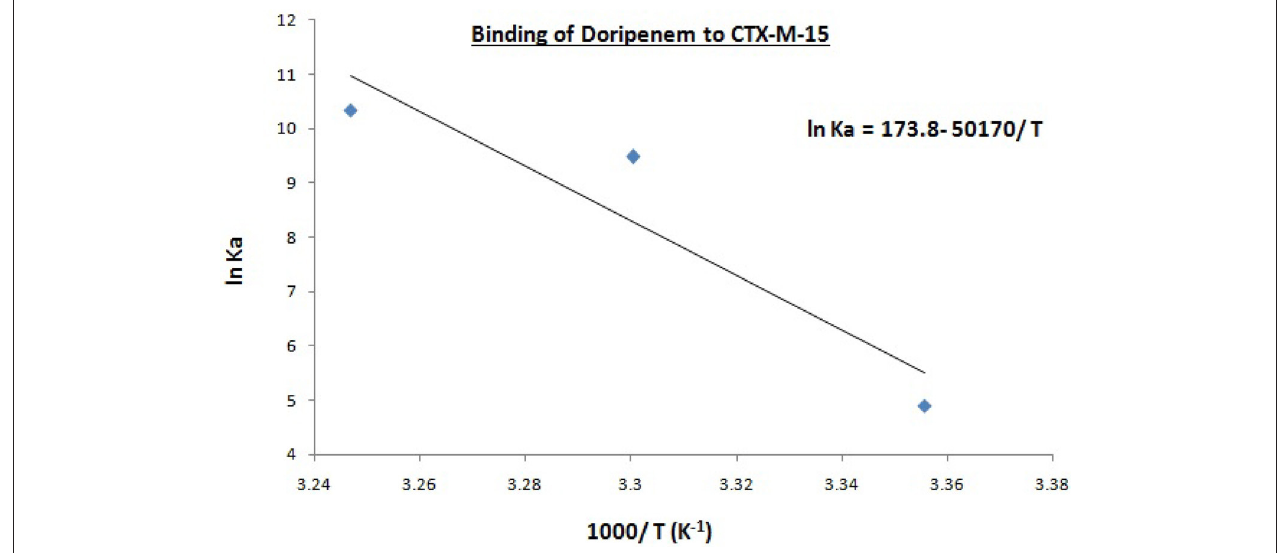
FIGURE 6 | Van’t Hoff plot for the binding of doripenem to 2 µ M CTX-M-15 at 298, 303, and 308K in the presence of doripenem (0 to 30 µ M ) in 50 mM sodium phosphate buffer at pH 7.4 is shown.